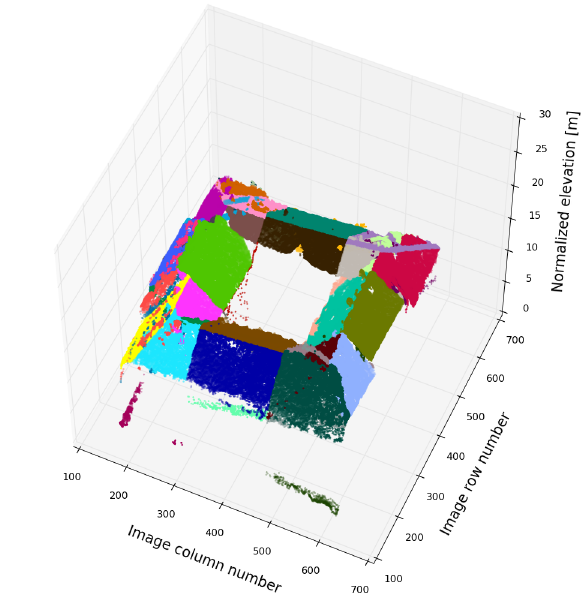
Figure 9: Found plane inliers after applying RANSAC to the building (500 iterations, distance threshold of 0.4). The colours imply different